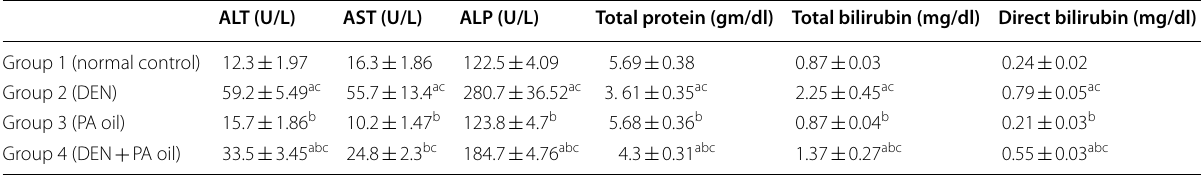
The data is presented as Mean a Significant to normal control group ( P b Significant to DEN group ( P c Significant to PA oil group ( P